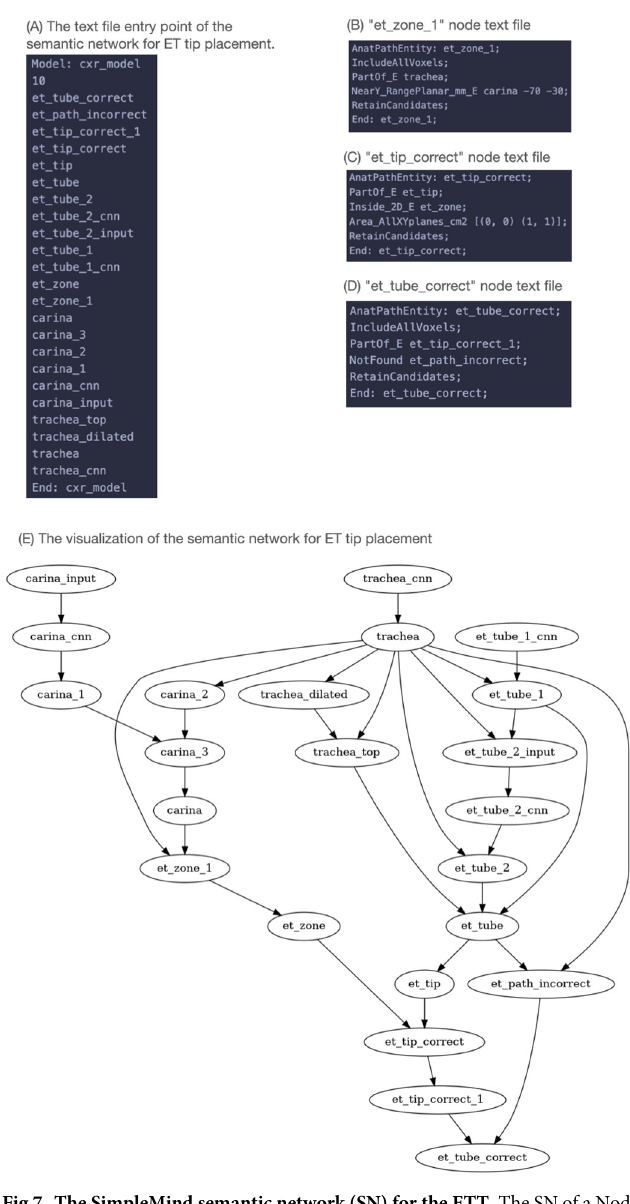
Fig 7. The SimpleMind semantic network (SN) for the ETT. The SN of a Node List file listing the nodes in the SN and the corresponding set of human readable node files. (A) The endotracheal tube SN Node List file. (B) The et_zone_1 node file. (C) The et_tip_correct node file. (D) The et_tube_correct node file. (E) Graph visualization of the endotracheal tube SN.